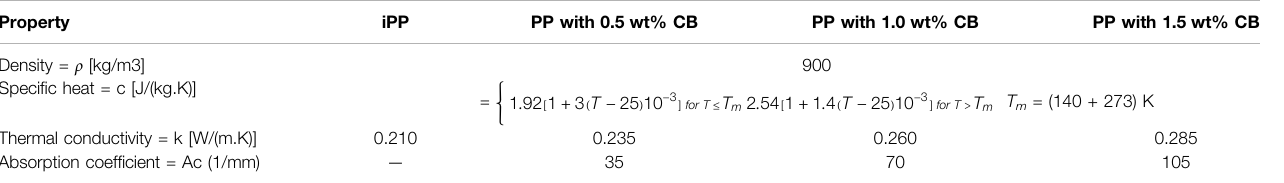
TABLE 1 | Thermophysical and optical properties of the PP used in simulations. Property